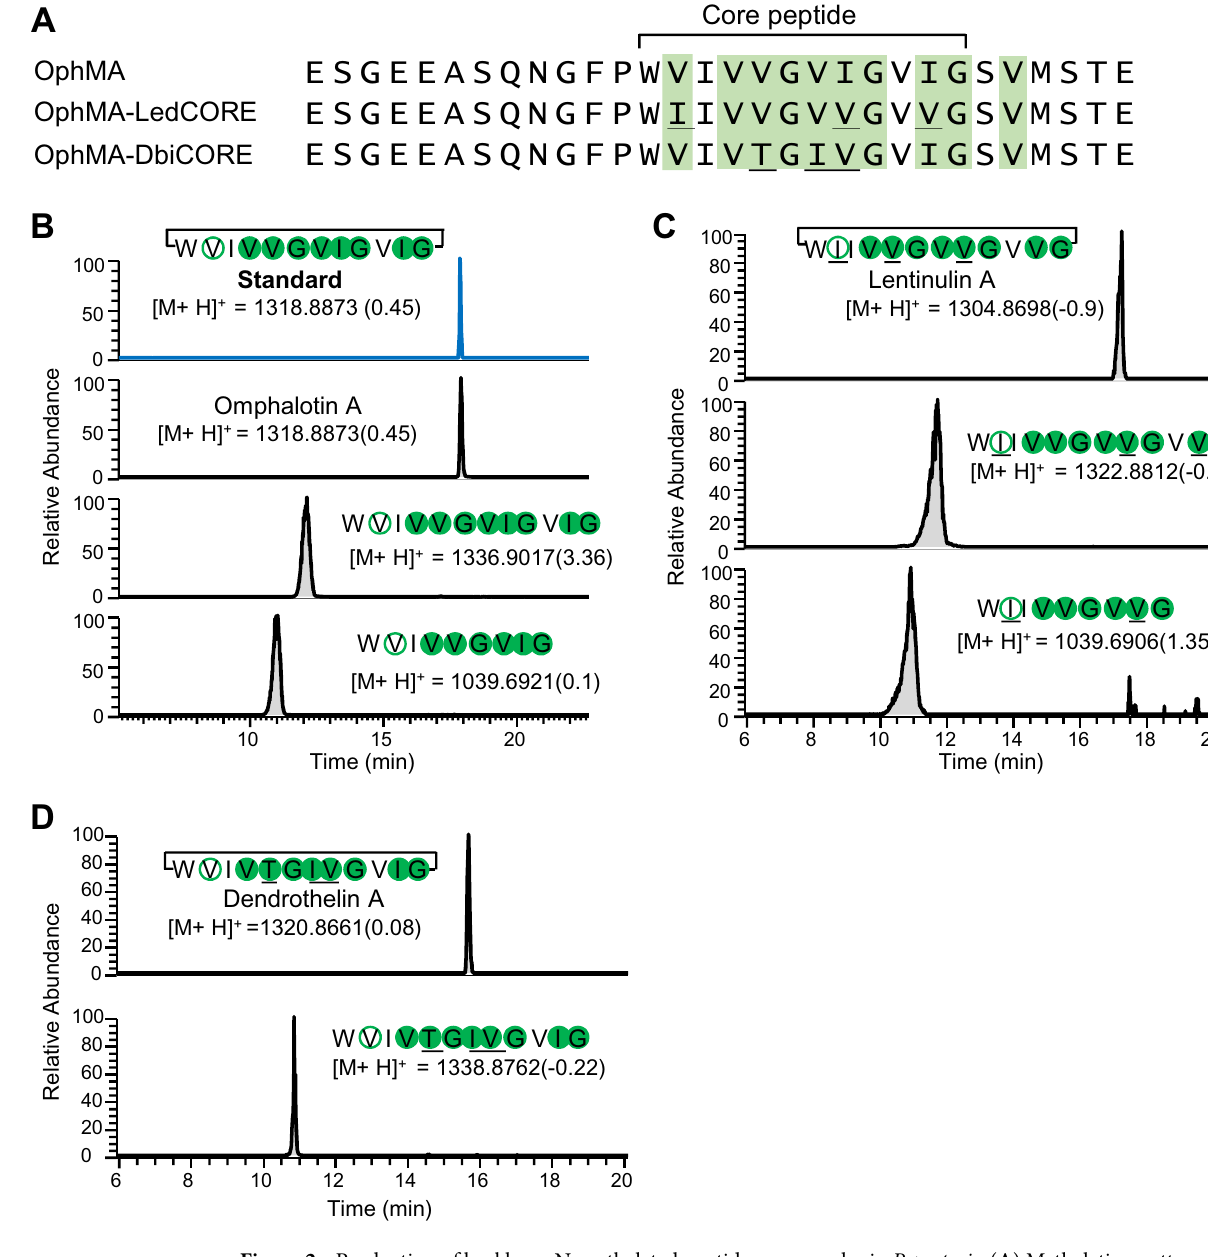
Figure 2. Production of backbone N-methylated peptide macrocycles in P. pastoris . ( A ) Methylation pattern of OphMA, OphMA_LedCORE and OphMA_DbiCORE. Methylated residues were determined by LC–MS/ MS analysis of the C-terminal tryptic fragments and are shaded in green (Supplementary Fig. S2A–C). ( B ) Production of omphalotin A. The extracted compound was detected using LC–MS and compared to the chemically synthesized omphalotin A standard (216 ng/ml). In addition to omphalotin A, fully methylated, linear (core) peptides and short linear peptides lacking the C-terminal three residues (VIG) were detected. ( C ) Production of lentinulin A and ( D ) dendrothelin A. The detected peptides were confirmed by LC–MS/MS. The confirmed positions of methylation are depicted using filled circles, while methylated residues inferred from MS/MS are shown in open circles. Residues different from omphalotin A are underlined. The mass difference (represented in ppm) between observed values and theoretical mass is indicated in brackets for each